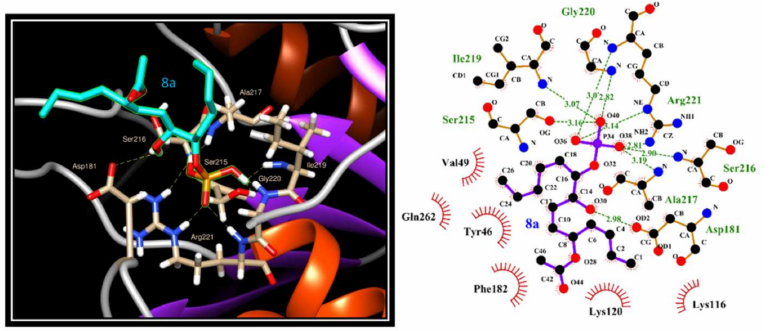
Figure 8. Visualization of the interaction between compound 8a and the active site of